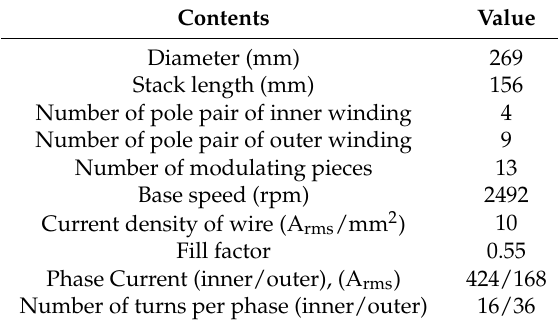
Table 1. Specifications of the analysis model.